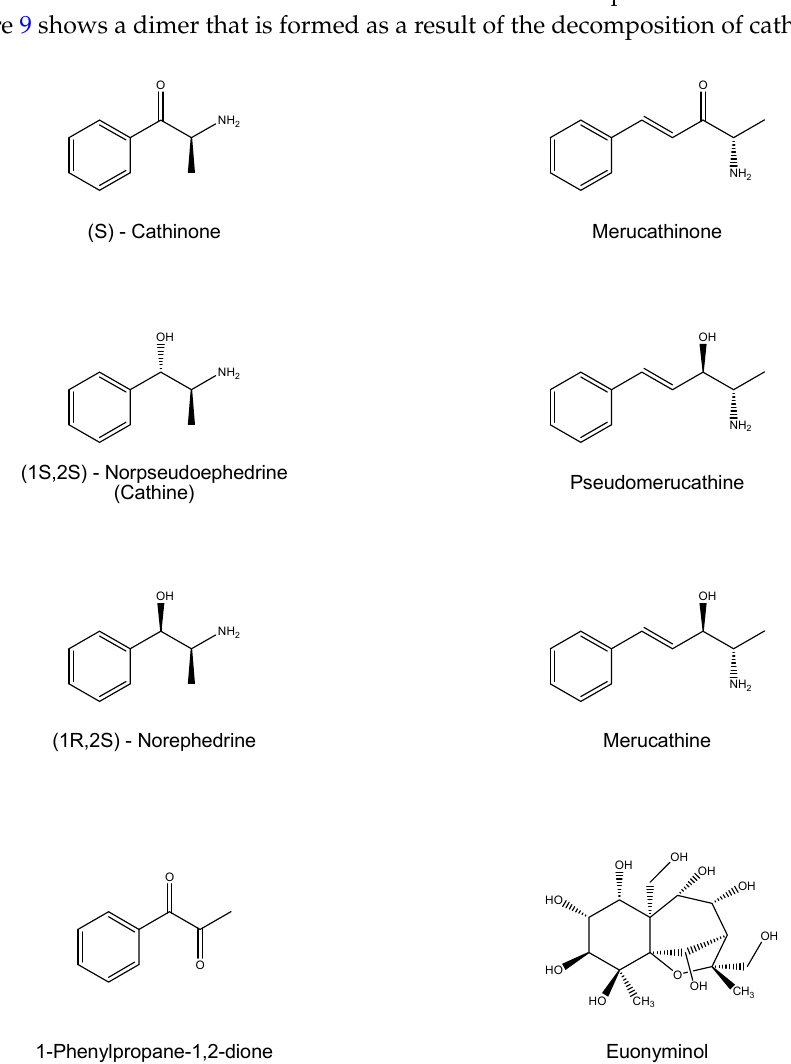
Figure 8. Chemical structures of the most abundant alkaloids present in leaves of Catha edulis.